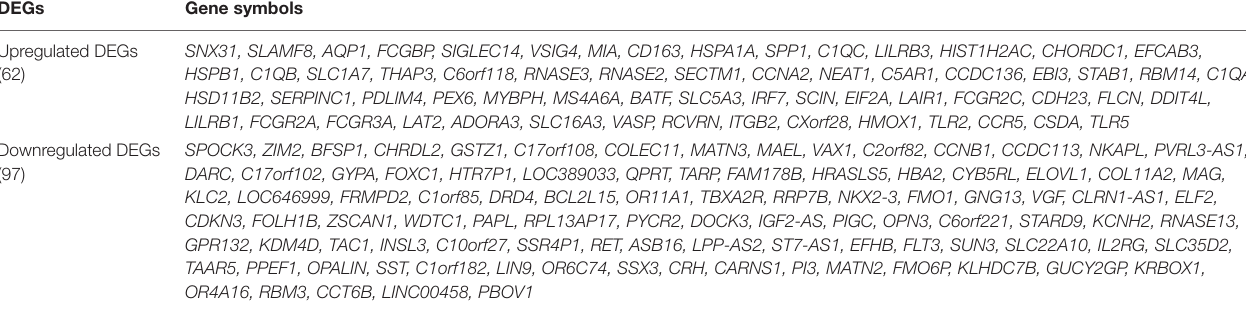
TABLE 1 | Differentially expressed genes (DEGs) that overlap in the frontal cortex and temporal cortex of vascular dementia. DEGs Gene symbols Upregulated DEGs